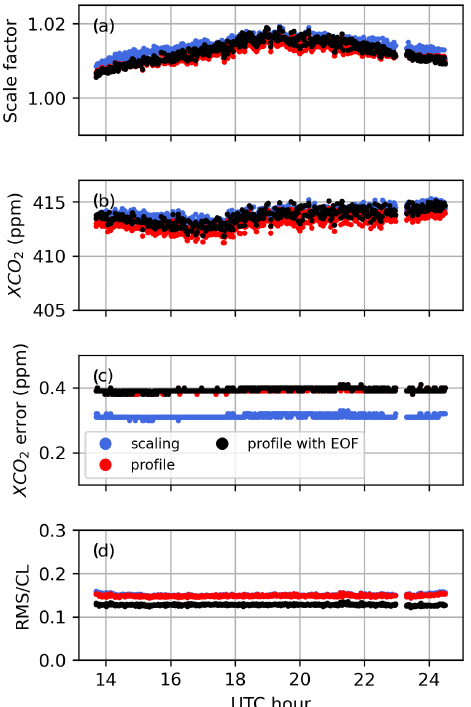
Figure E6. Same as Fig. E2 but for the Weak2 window. large deviations typical of temperature errors like that in Fig. 9b, the CO 2 profile obtained from profile retrieval with the first EOF reduces the amplitude of the deviations, but the shape persists. This is expected as the first EOF represents the average residuals, which should not include residual fea- tures caused by temperature errors, unless the temperature errors were always biased in the same way. We would expect the first EOF to reduce deviations like that in Fig. 9a. In such cases, the CO 2 profiles obtained from profile retrieval with the first EOF are smoother than profile retrievals but present no clear advantage over scaling